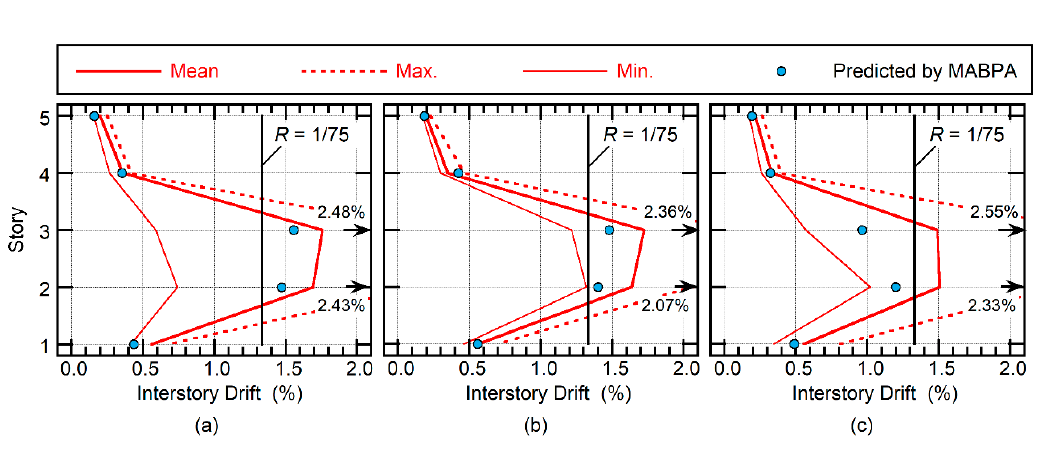
Original image of Figure 23: